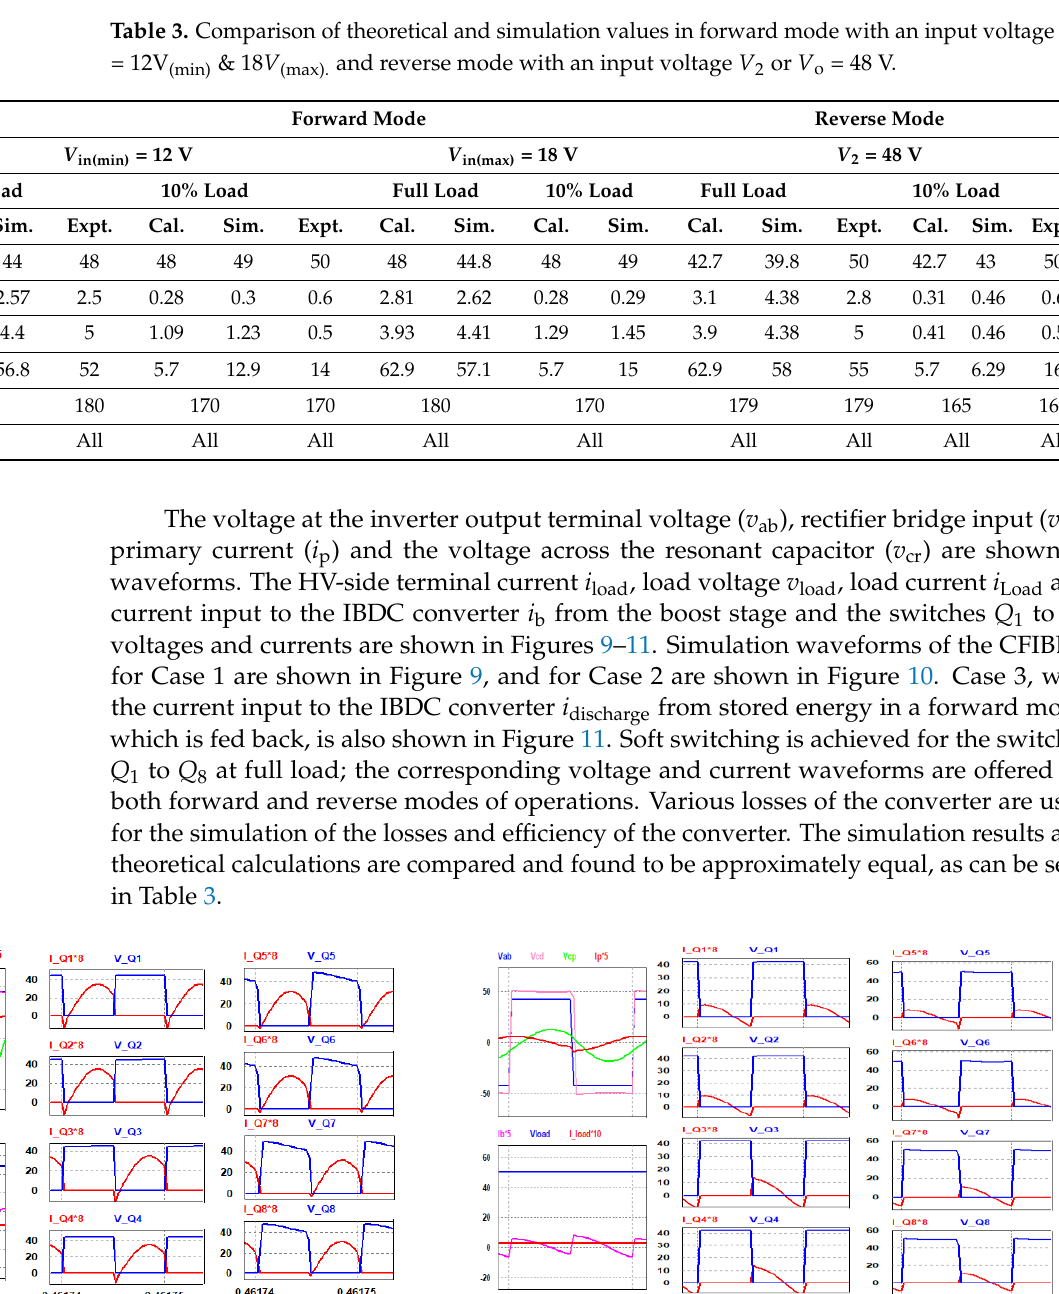
Figure 10. ( a ). Simulation results in FM mode with 100% Load at V in(max) = 18 V, v ab , v cd , i p and v cr . Soft-switching characteristics for the primary ( Q 1 to Q 4 ) and secondary side ( Q 5 to Q 8 ) switches are also shown. ( b ). Simulation results in forward mode (FM) with 10% Load at V in(max) = 18 V, v ab , v cd , i p and v cr . Soft-switching characteristics for the primary ( Q 1 to Q 4 ) and secondary side ( Q 5 to Q 8 ) switches are also shown.